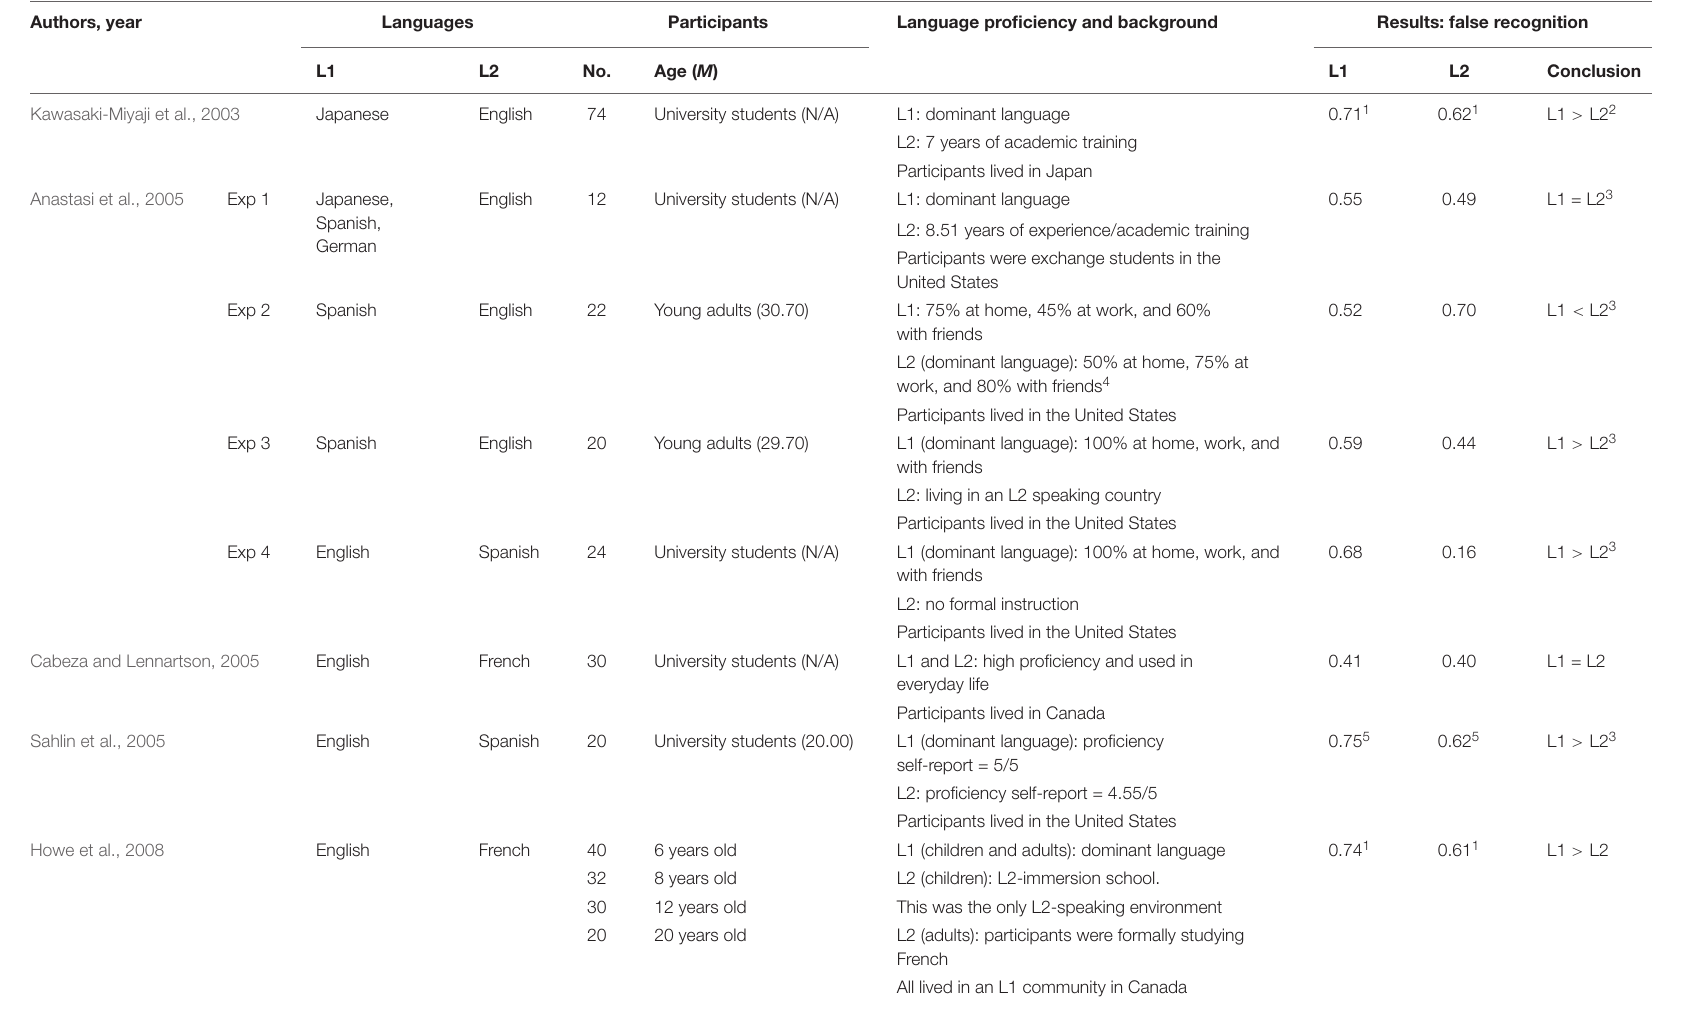
TABLE 1 | Summary of the reviewed studies on the role of language proficiency in false recognition. Authors,